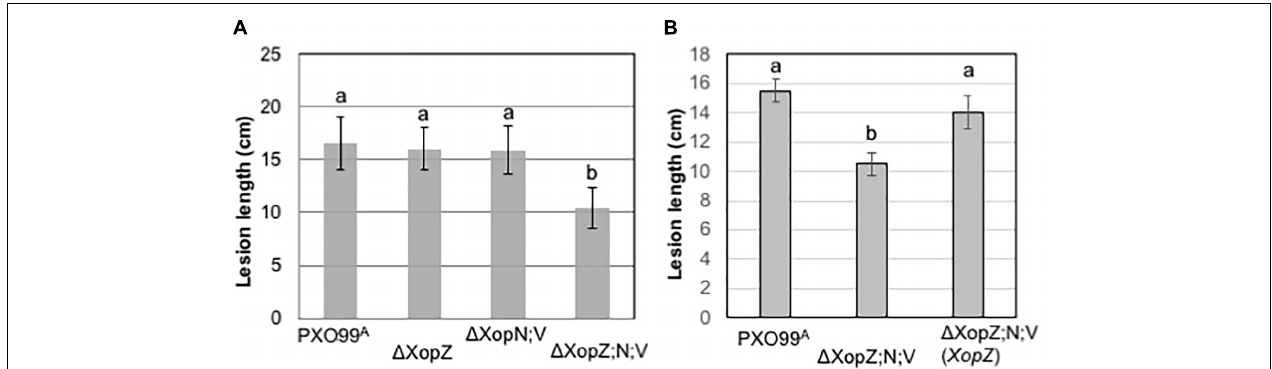
FIGURE 4 | Non-TAL effectors XopZ, XopV, and XopN function in the pathogenicity of Xoo PXO99 A in rice. (A,B) Measurements of lesion lengths caused by PXO99 A and its derivatives mutants as indicated below each column. The measurements each were obtained from 10 leaves of five rice plants of Kitaake (two leaves per plant). Values with the same lowercase letters above columns do not differ significantly at the < 0.5 level using Tukey statistics and ANOVA analysis. Bars indicate standard deviation (SD).